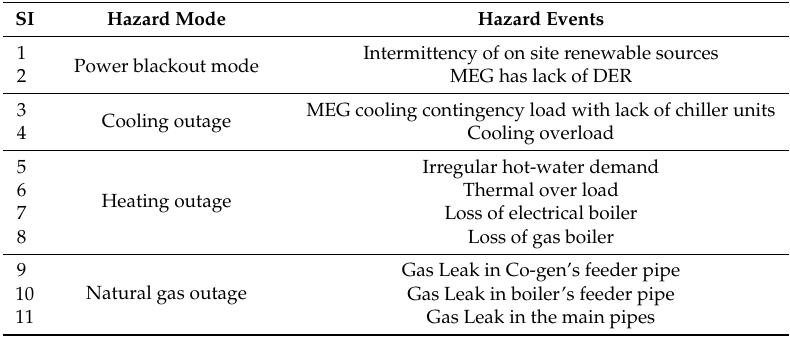
Table 4. Hazard events in marginal risk range.